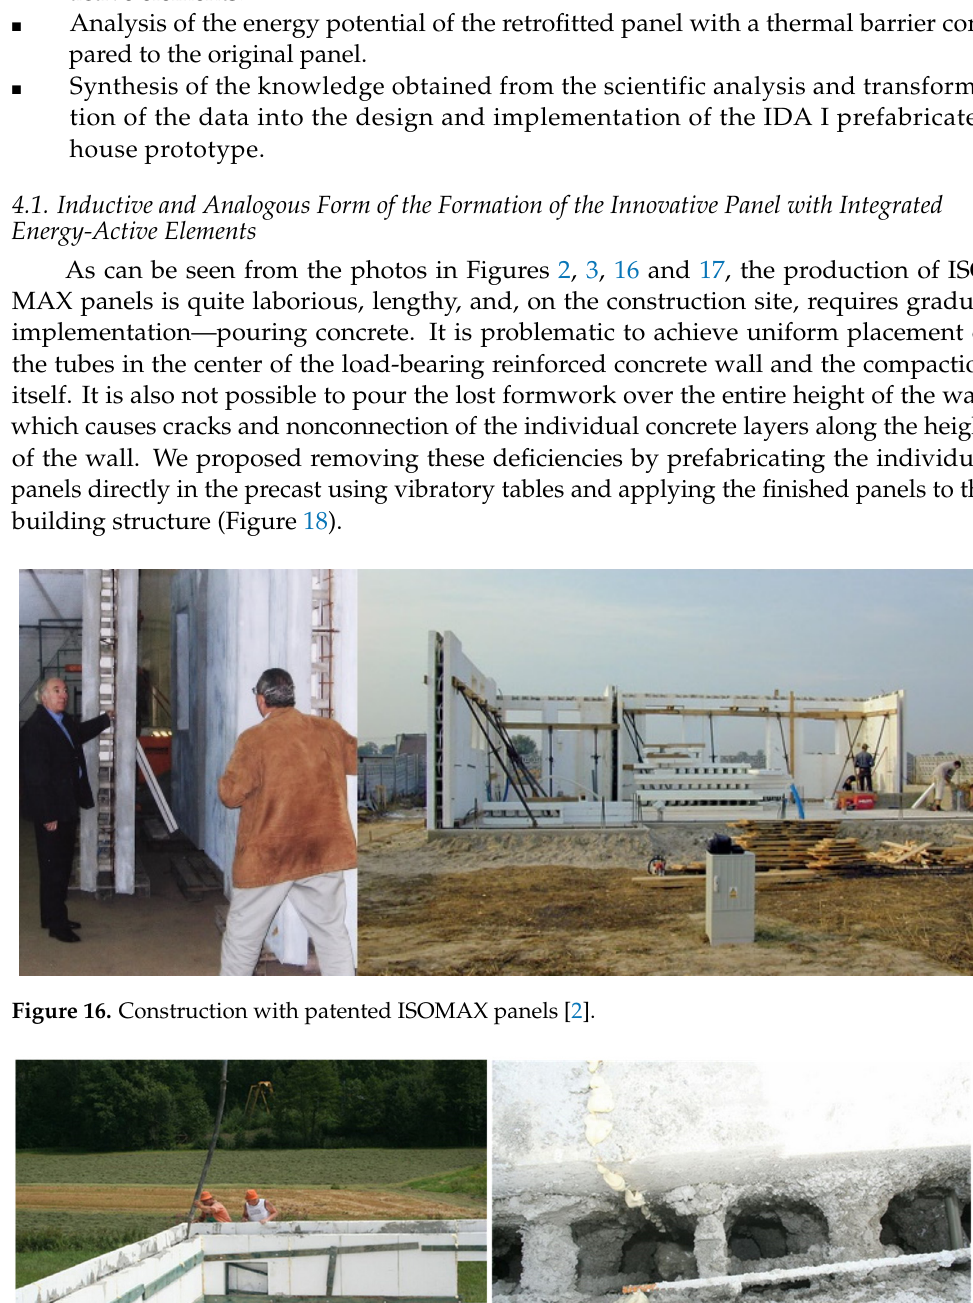
Figure 15. “Detail E”, the joint of the perimeter panel with the base plate. The colored points (red and blue) in the picture are thermal barrier pipes.